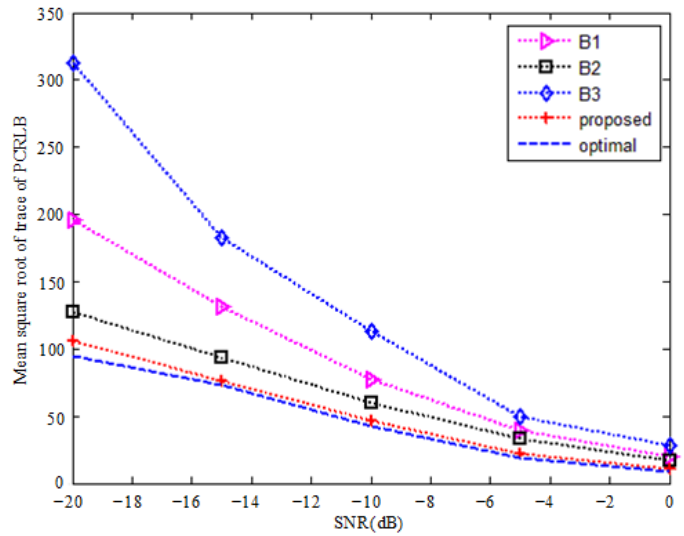
Figure 6. Mean square root of trace of PCRLB.